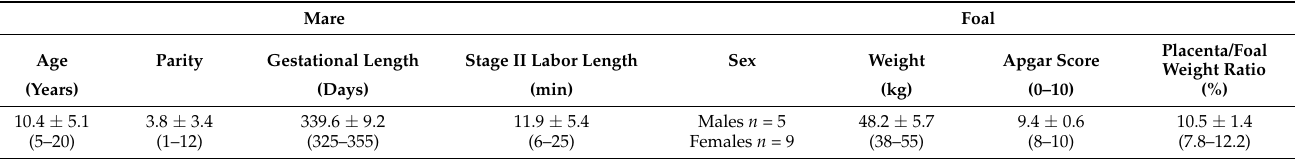
Table 2. Clinical data collected from mares and foals born from attended parturition. n = number of animals. Data are expressed as mean ± standard deviation